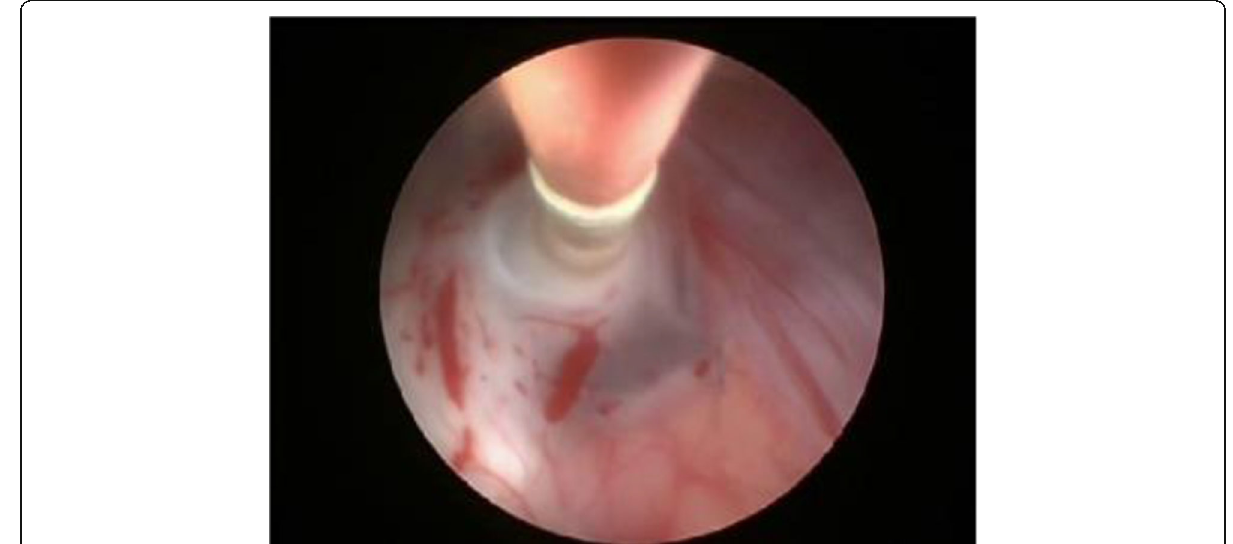
Fig. 2 Endoscopic view showing widening of a fenestration with Fogarty